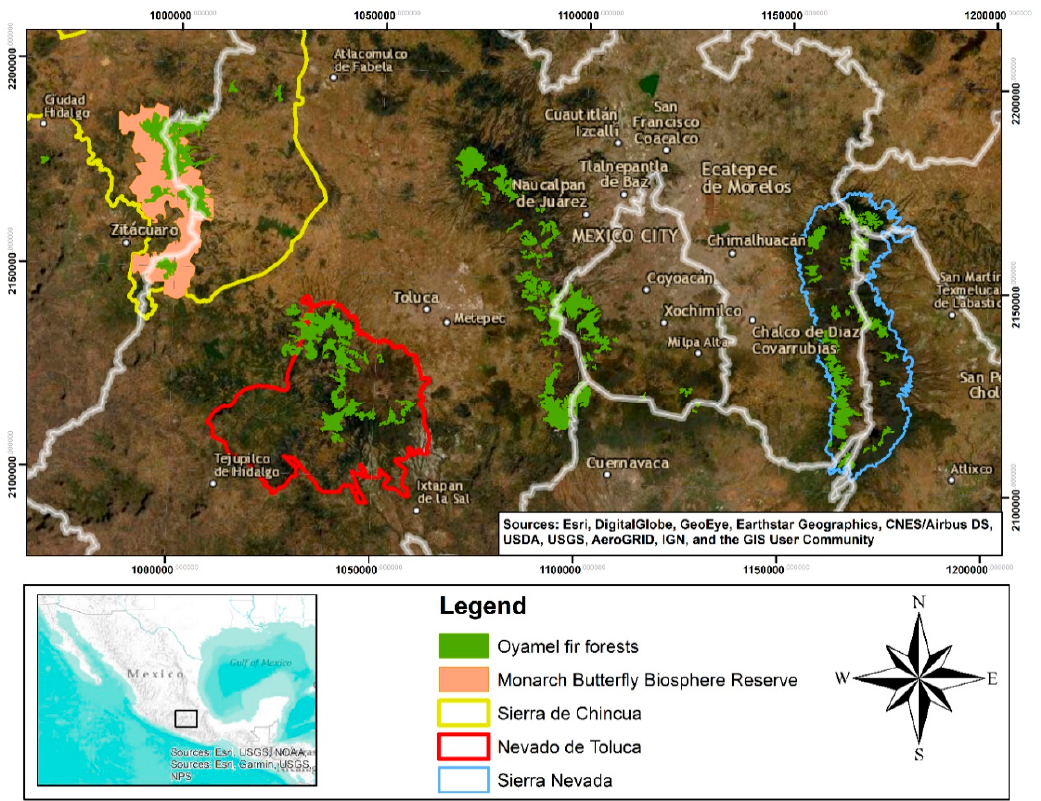
Figure 1. Location of the study area.